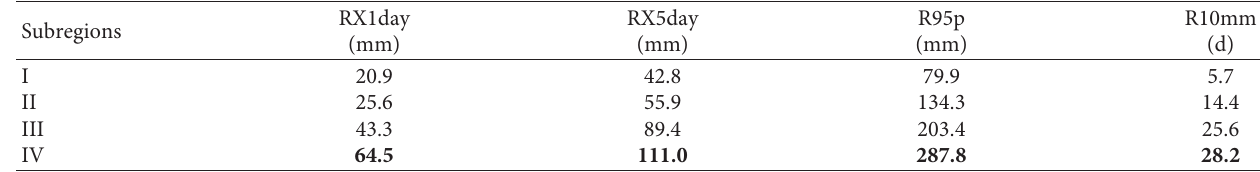
Bold values show the largest mean